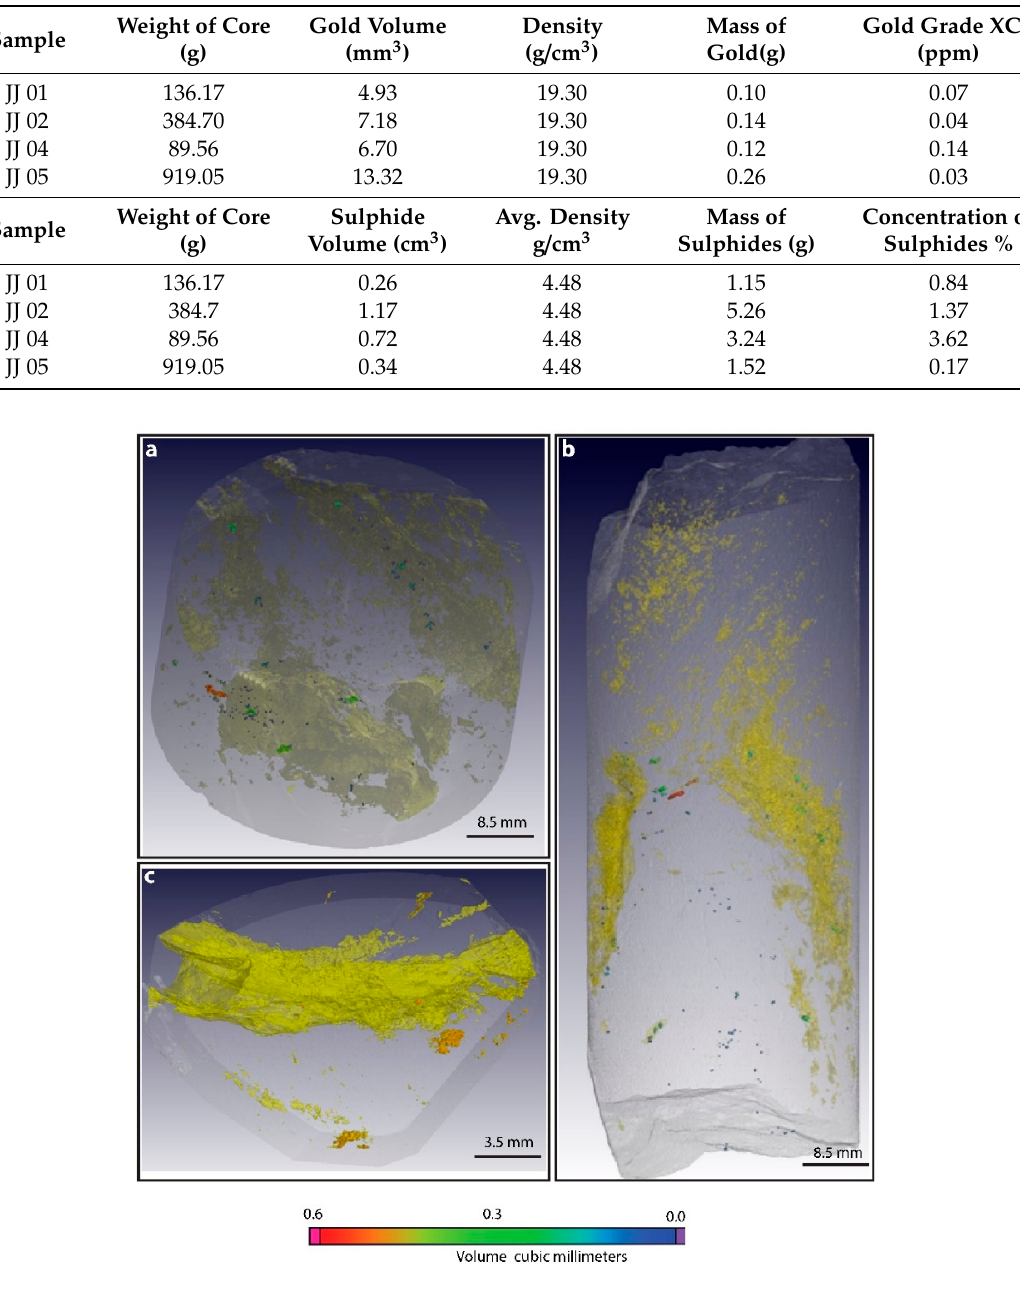
Figure 4. ( a , b ) XCT images showing 3D distribution of gold in mineralized drill core samples from gold-rich hydrothermal veins. The grey colour is the silicate matrix, the yellow colour indicates sulphides and the other colours represent gold, distributed according to gold grain volume (warm colours = large grains, cold colours = smaller grains). Samples JJ01 and JJ05 ( c ) is a thick section made from sample JJ04.